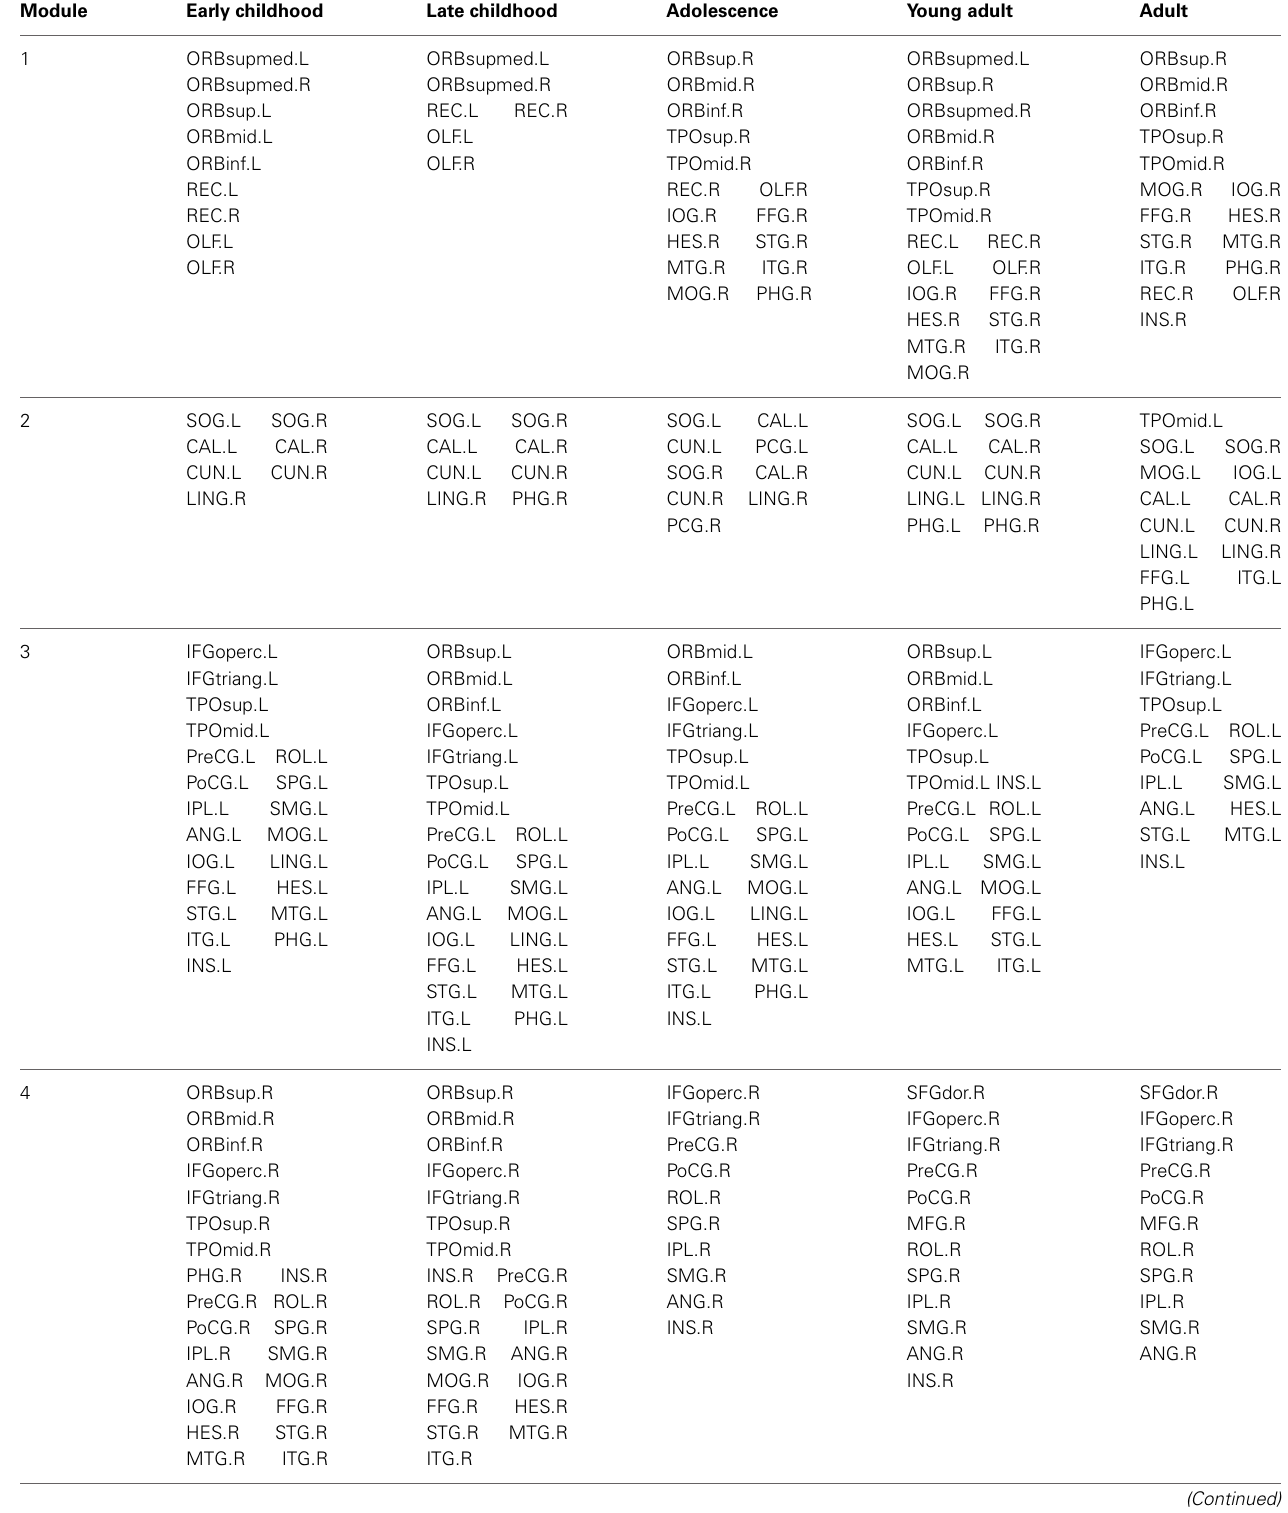
Table 3 | Cortical regions in each module of developing white matter